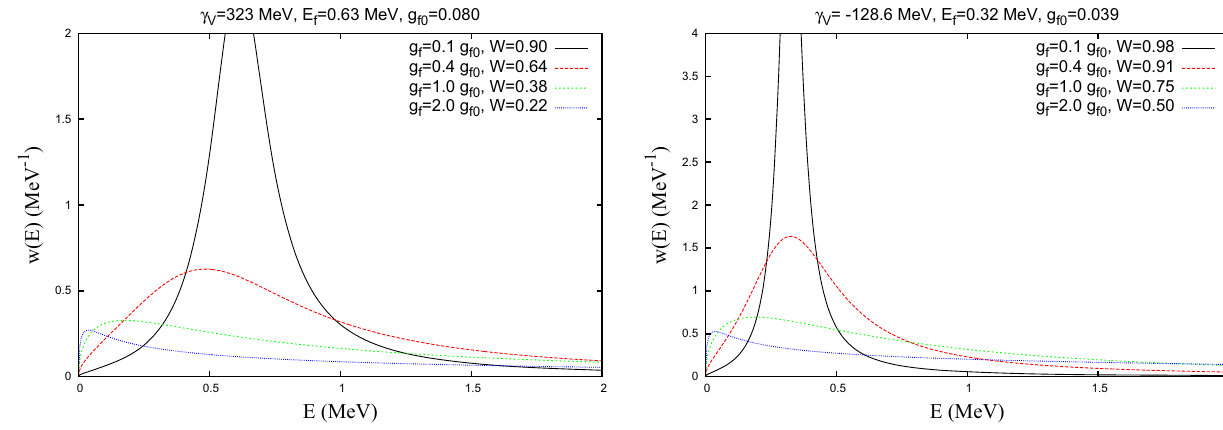
Fig. 7 Spectral density function for case 2.I ( left ) and case 2.II ( right panel ) for several values of g f , with E f and γ V fixed. The value of W is also indicated in the legends for each entry of g f √ with (cid:23) = 2 μ | E R | . Their positions in the energy plane, E = k 2 / 2 μ − i (cid:4) ∗ / 2,